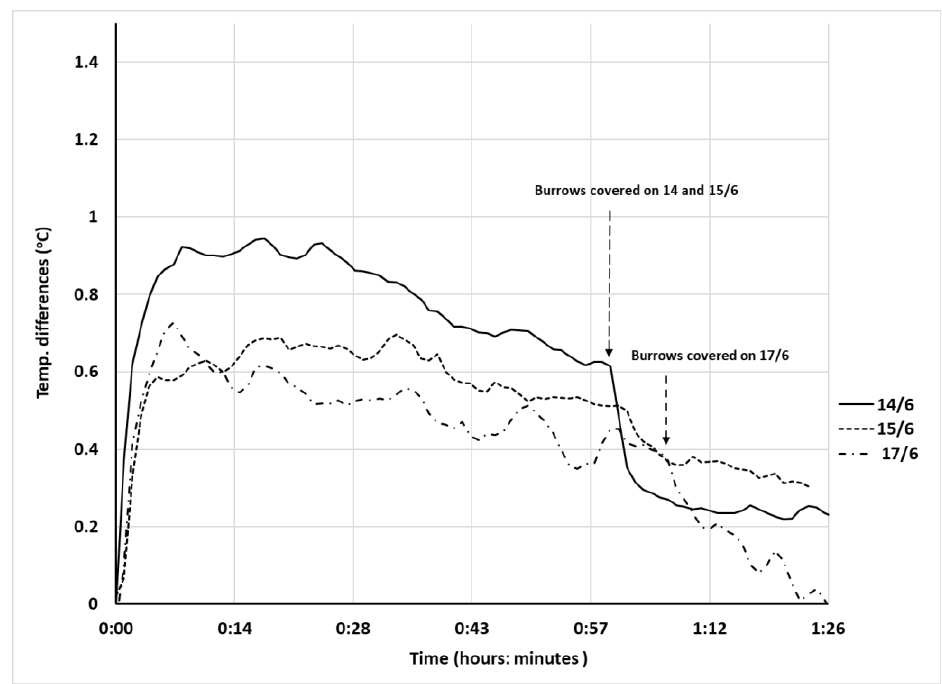
Figure 3. Differences between averaged temperature differences (Δ T t , see text for definition) in ºC of open and closed Lycosa hyraculus burrows over three dates (14/6, 15/6, and 17/6) as a function of time elapsed after door removal. Error bars are omitted for clarity.